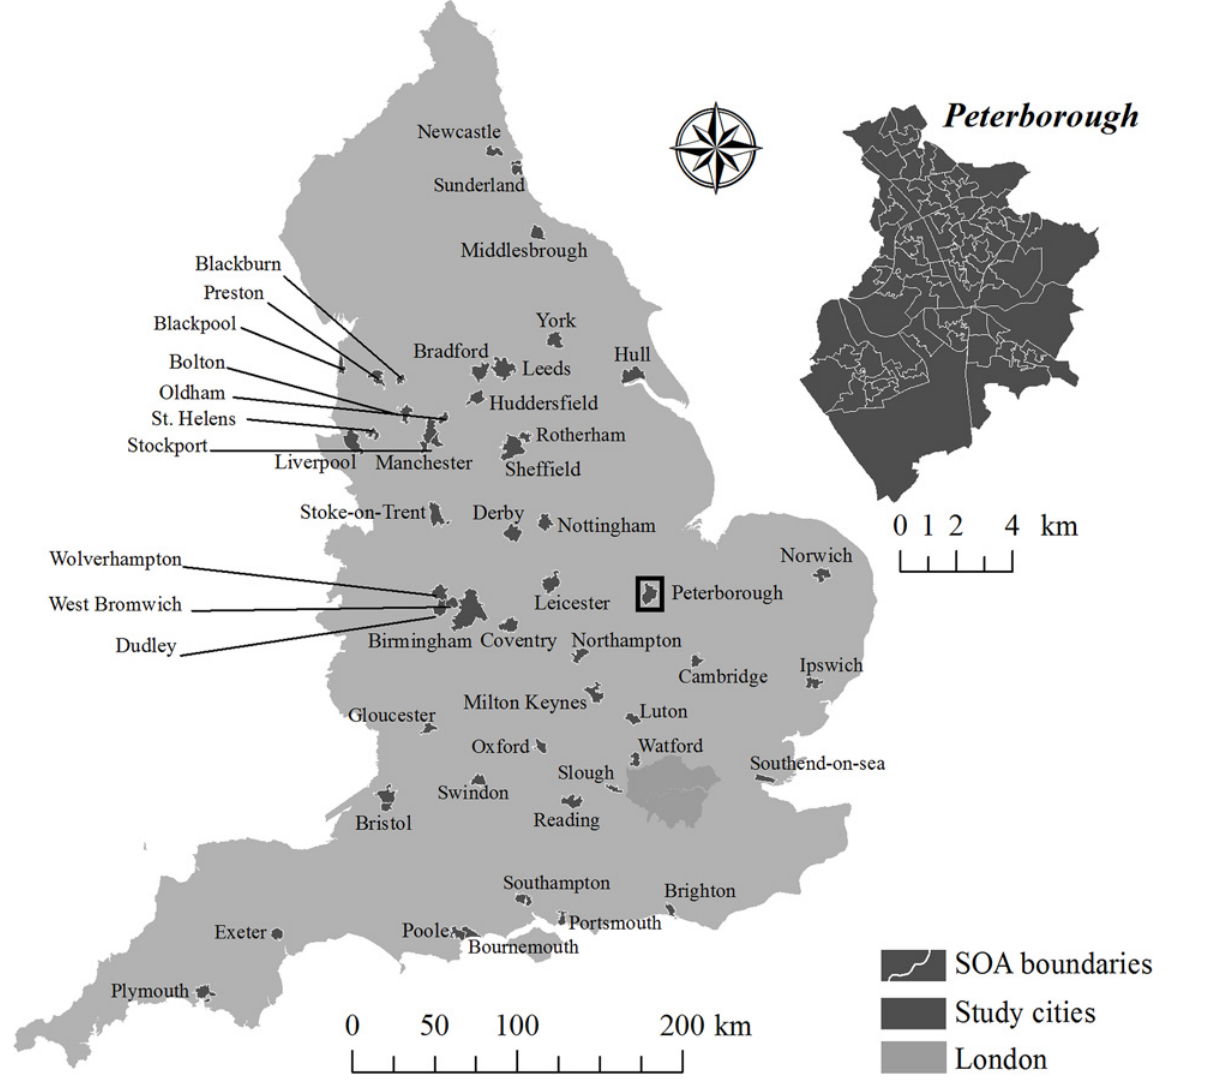
Fig 1. Cities included in the study. The inset of Peterborough shows the construction of the city boundaries through aggregation of